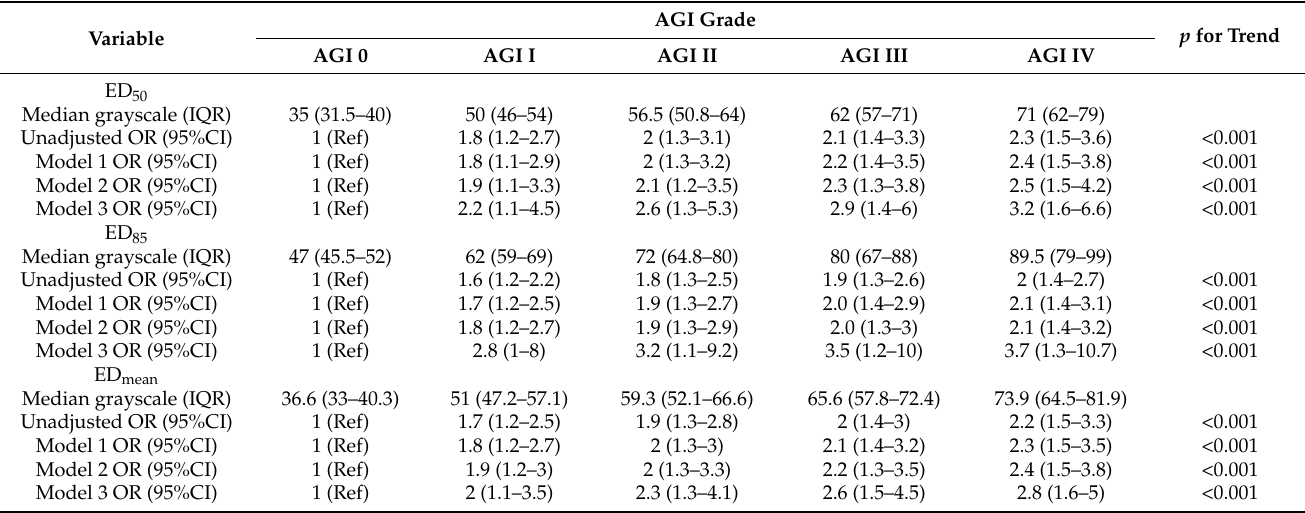
Figure 3. ( a – c ). Correlation of ED 50 , ED 85 , ED mean with AGI grade; ( d – f ). Boxplot of the change of ED 50 , ED 85 , ED mean with AGI grade. The trend test is mainly based on the median ED 50 , ED 85 , and ED mean of each AGI grade, which were input separately into the linear logistic regression model as continuous variables. AGI: acute gastrointestinal injury. *: p -value < 0.05. Table 2. Multivariable-adjusted association of ED 50 , ED 85 , ED mean with the severity of AGI